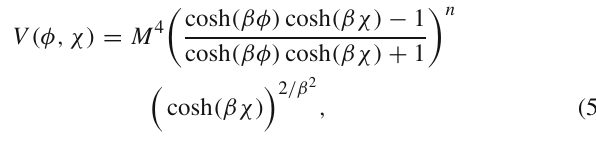
benchmark models used in the simulations. The last column shows the momentum space cutoff defined in Sect. 4.1